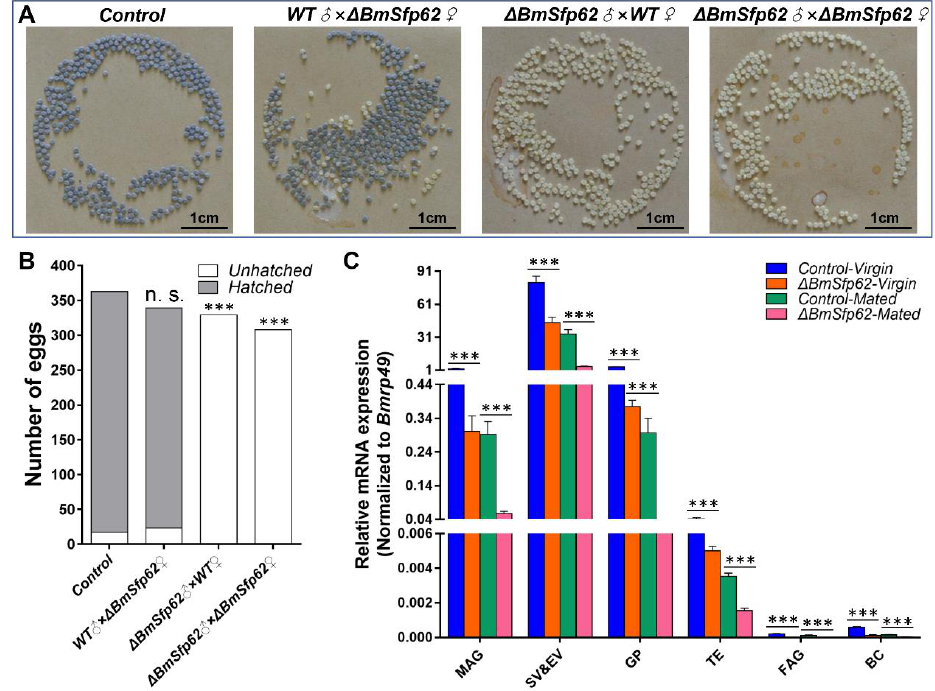
Figure 4. Deletion of BmSfp62 results in male sterility. ( A ) Eggs produced by crosses. ( B ) Eggs hatched and unhatched. ( C ) Relative mRNA expression of BmSfp62 in reproductive adult tissues. Virgin WT is in blue, virgin Δ BmSfp62 is in orange, mated WT is in green, and mated Δ BmSfp62 is in pink. BmSfp62 mRNA expression level was normalized to Bmrp49 . The data shown are means ± S.E.M. ( n = 3). Asterisks indicate significant differences with a two-tailed t -test: *** p < 0.001; n. s. p > 0.05.